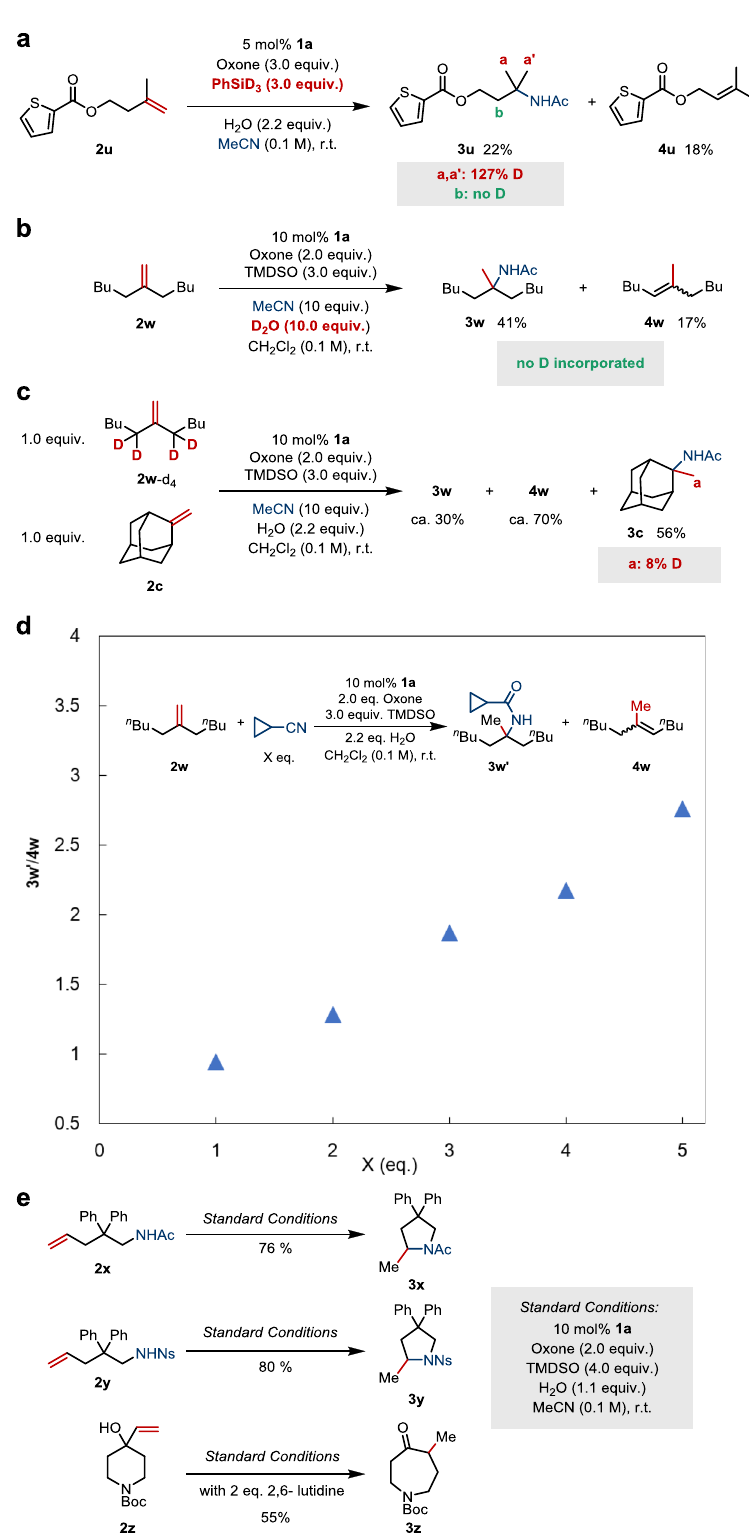
Fig. 5 Mechanistic investigation. a With deuterium-labeled silane. b Test for proton activation. c Test for reversibility of HAT. d Effect of the amount of nitrile. e Tests of alternative